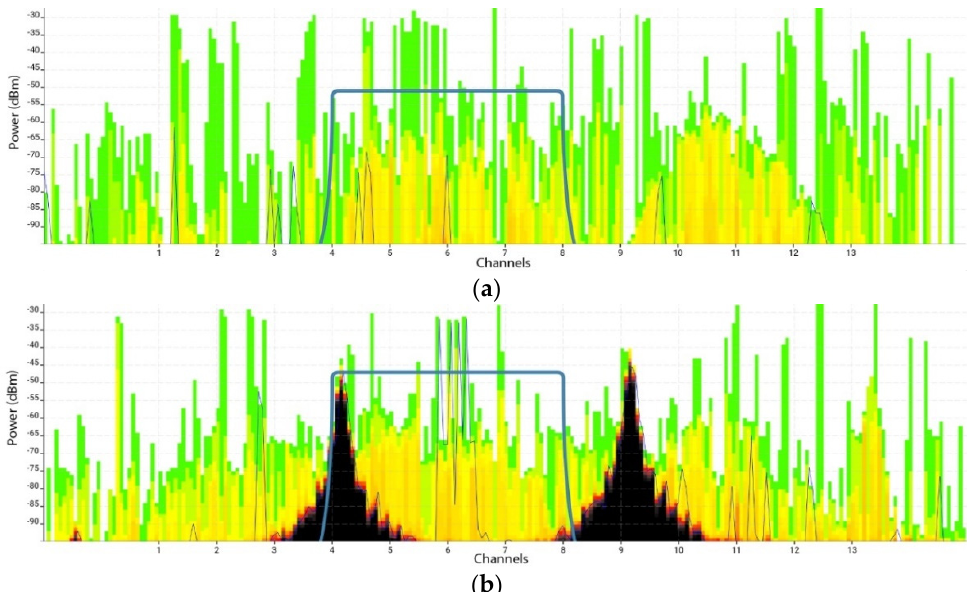
Figure 6. Time-averaged view of radiofrequency spectrum on the physical (PHY) layer on the 2.4 GHz band in the ( a ) no interference and ( b ) interference scenarios by averaging over 20 s. The blue line represents d_8 signal, while the two black peaks indicate signal from the sound transmitter. Darker color indicates greater channel use.